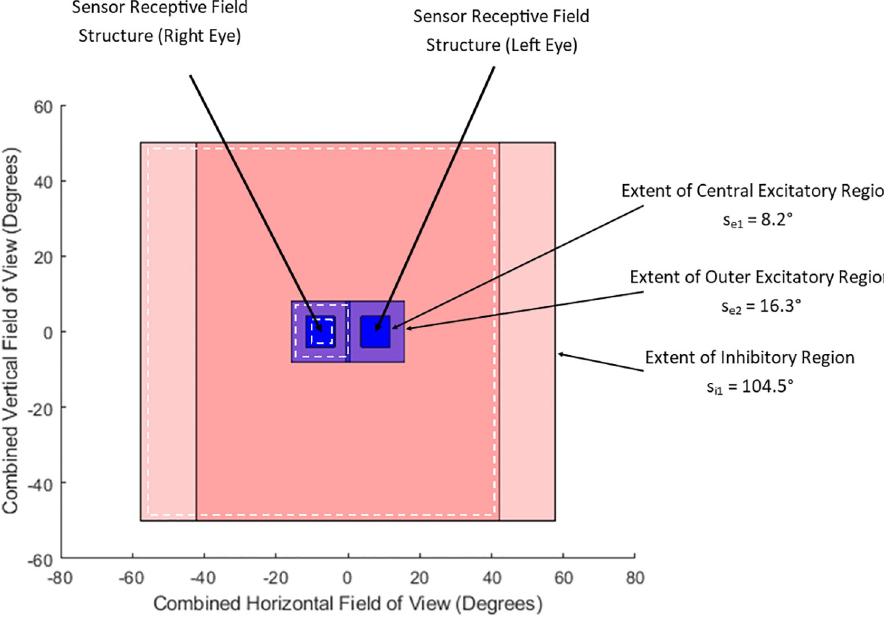
Fig 6. The image shows left- and right-eye receptive fields, superimposed and backprojected onto a screen at 10cm distance for ease of comparison with the stimuli. The left- and right-eye receptive fields have identical structures, with a central strongly excitatory region (blue) surrounded by an outer, more weakly excitatory region (purple), and then by a much larger inhibitory region (pink). The receptive fields in the two eyes appear offset horizontally on the screen by the screen disparity d = 15.4˚.